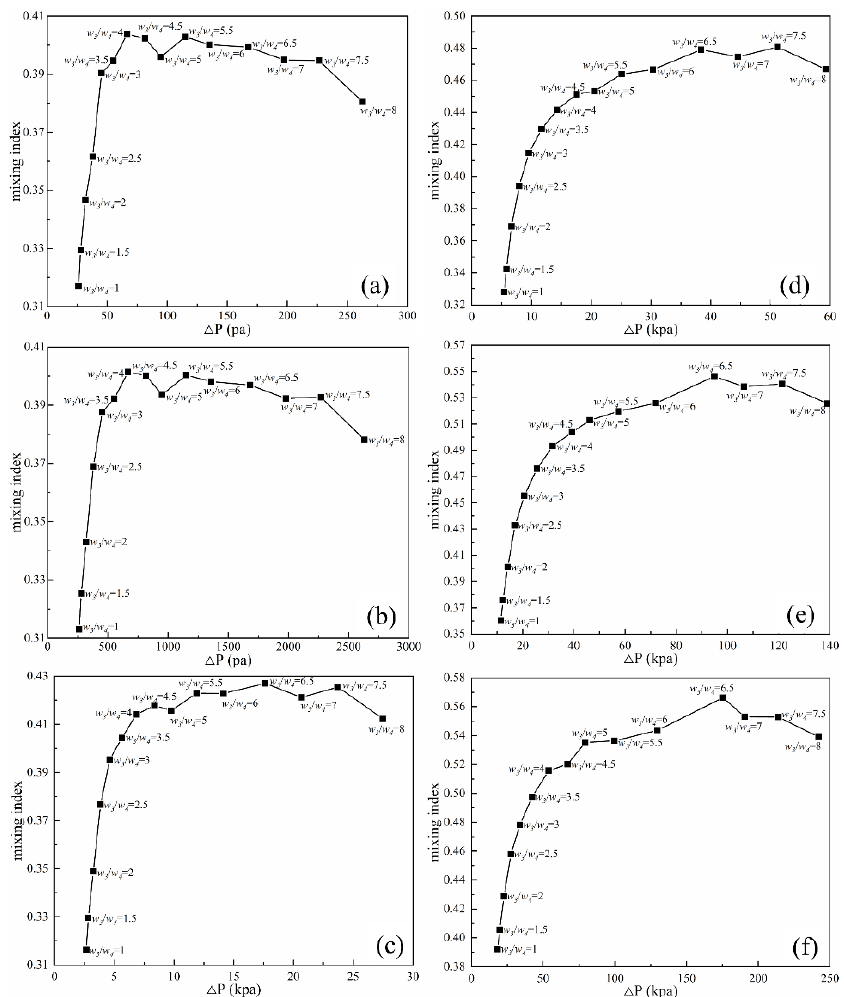
Figure 13. Mixing performance map. ( a ) Re = 0.1; ( b ) Re = 1; ( c ) Re = 10; ( d ) Re = 20; ( e ) Re = 40; ( f ) Re = 60.